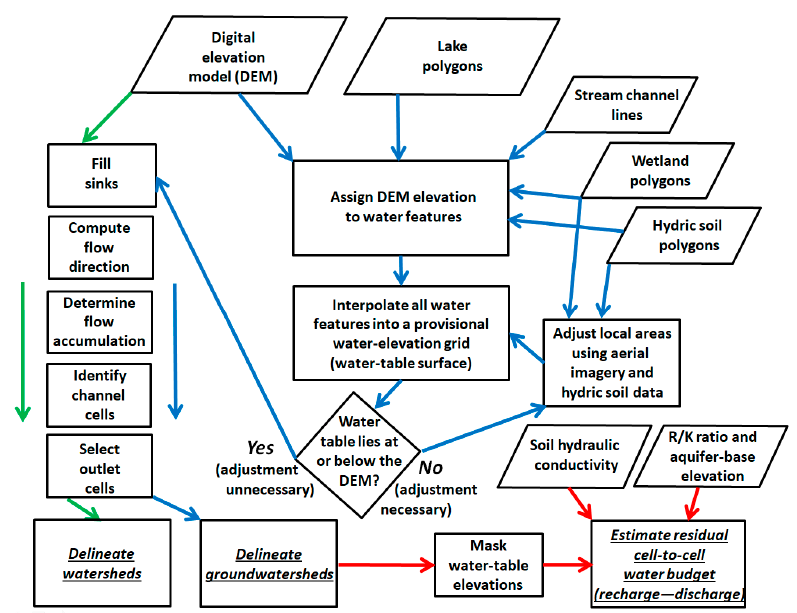
Figure 3. Work flow of the GIS-based technique. Parallelograms show data sources, rectangles indicate processes, and the diamond shows a decision. Blue, green, and red arrows show the groundwater, surface water, and groundwater analysis operations. Underlined titles indicate process goals.